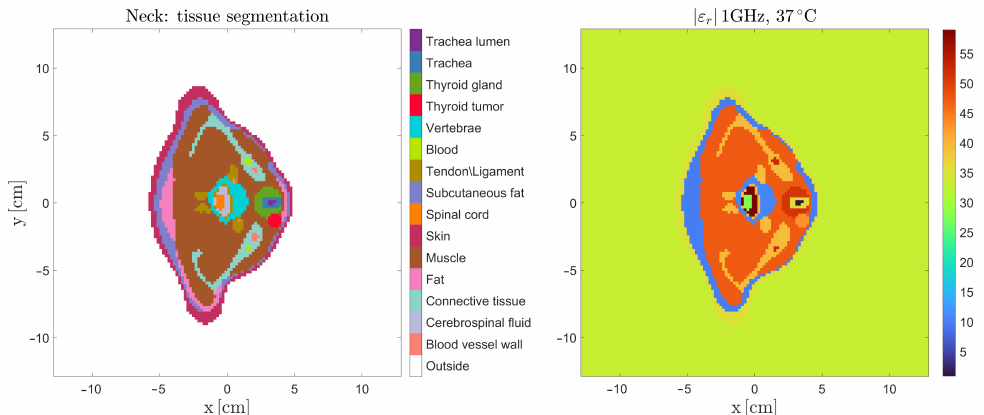
Figure 5. The phantom adopted for the numerical study. Tissue segmentation ( left ) and electromag- netic properties ( right